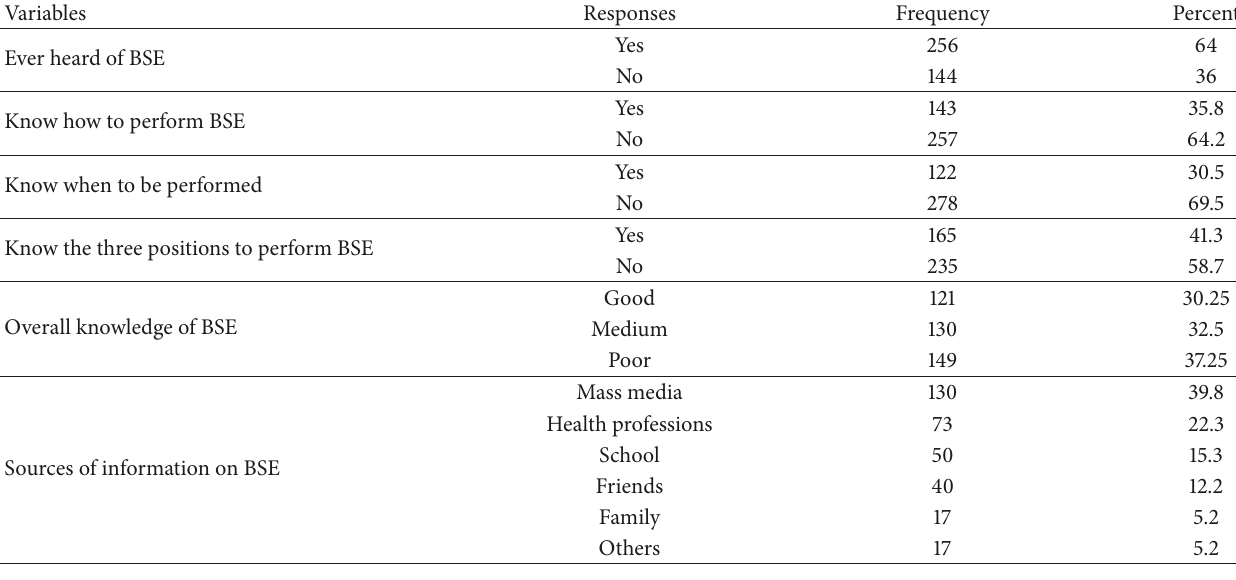
Table 2: Knowledge about BSE among female DBU students.